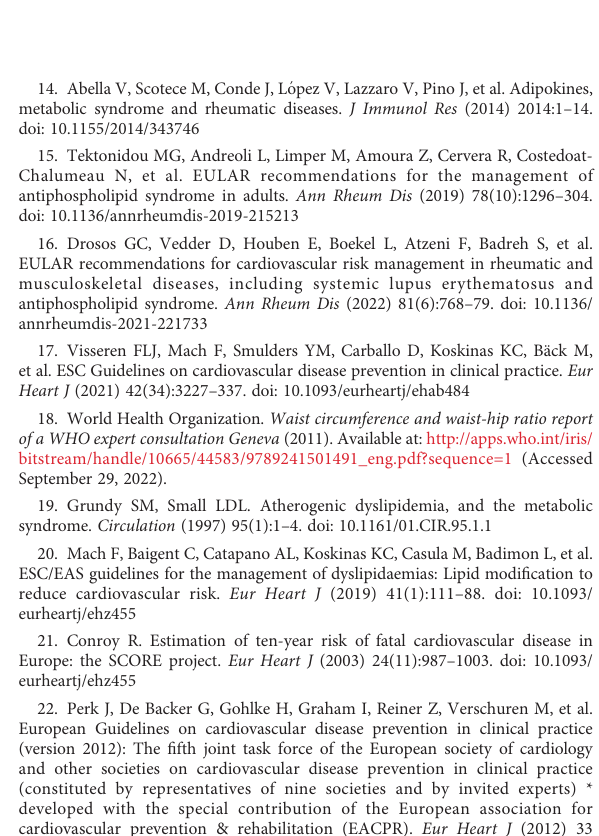
SUPPLEMENTARY TABLE 1 Criteria for the clinical diagnosis of metabolic syndrome based on different sets of diagnostic criteria SUPPLEMENTARY TABLE 2 Univariate determinants for the presence of metabolic syndrome in